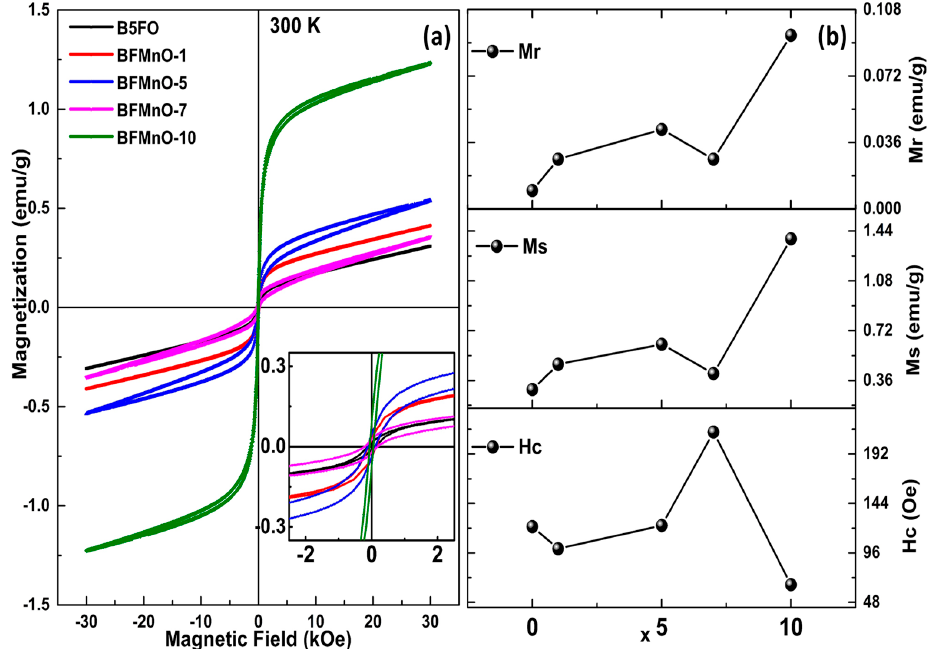
Figure 8. ( a ) M-H hysteresis curves of BFO, BFMO1, BFMO3, BFMO5, BFO7, and BFMO10; inset shows the behavior of the curves near H = 0, ( b ) Variation of Mr, Ms, and Hc as a function of Mn concentration.